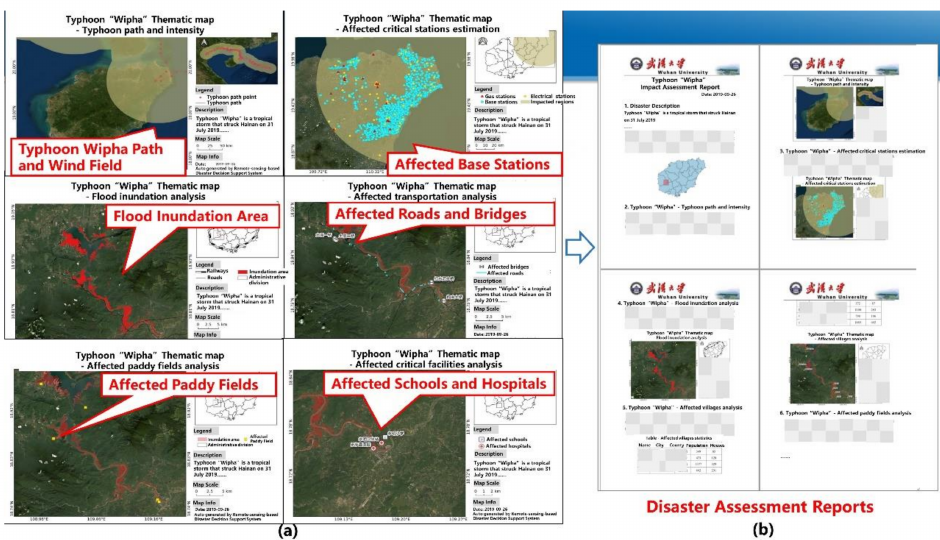
Figure 7. System application on Typhoon “Wipha”. ( a ) Thematic maps of typhoon track and wind field, affected base stations, flood inundation area, affected roads and bridges, affected schools and hospitals, affected paddy fields; ( b ) Disaster assessment